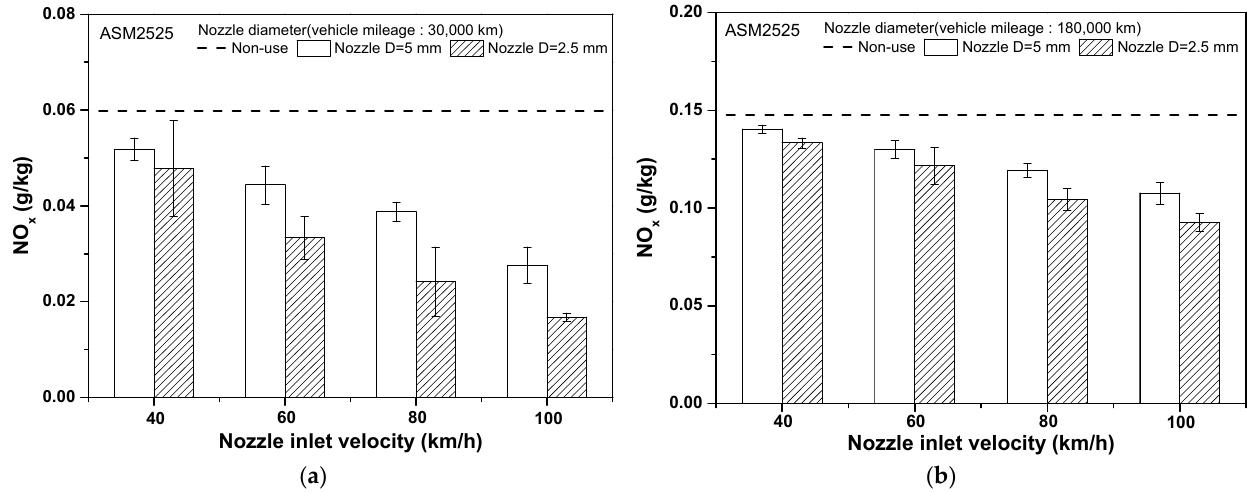
Figure 10. Variation in NO x according to nozzle diameter for 30,000 and 180,000 km mileage engines: ( a ) 30,000 km engine; ( b ) 180,000 km engine.